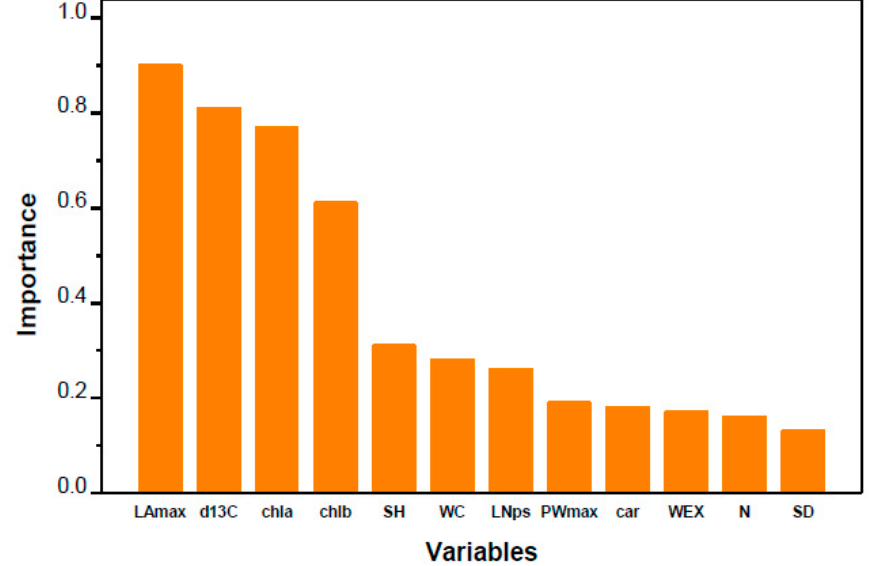
Figure 6. Relative importance values (Akaike weights) of the predictors using model averaging (MuMIn package in R). LA max : maximum leaf area; PW max : maximum petiole width; WEX: leaf width expansion rate; LN ps : leaf number per shoot; SD: shoot diameter; SH: shoot height; WC: foliar water